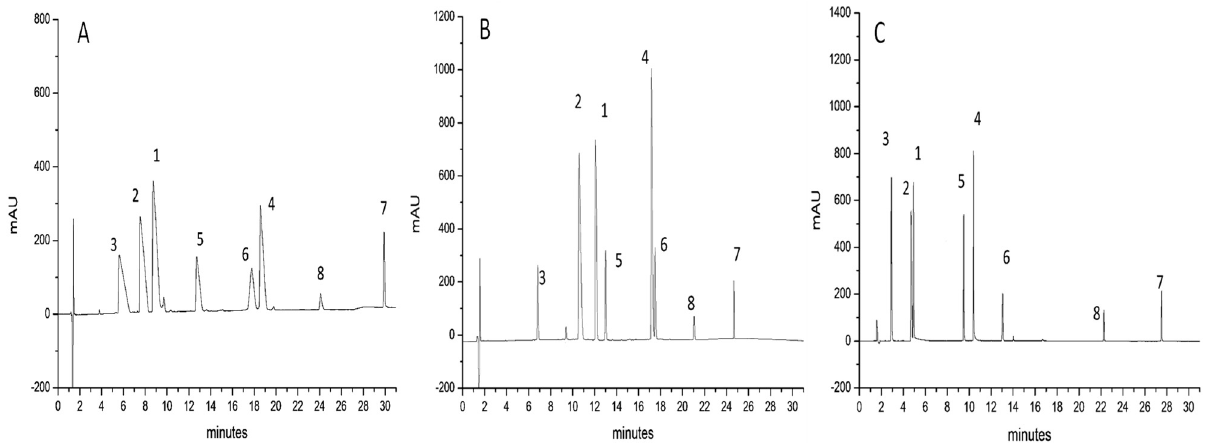
Figure 1. Chromatograms refer to the separation of eight peptides (see Table 1). Column used: ACQUITY UPLC ® BEH C18 (150 × 2.1 mm L × I.D.) 1.7 μ m 300 Å FPP and BEH particle. ( A ) MP with 0.1% v/v FA; ( B ) MP with 0.1% v/v TFA; ( C ) MP with 10 mM TBAHSO 4 .